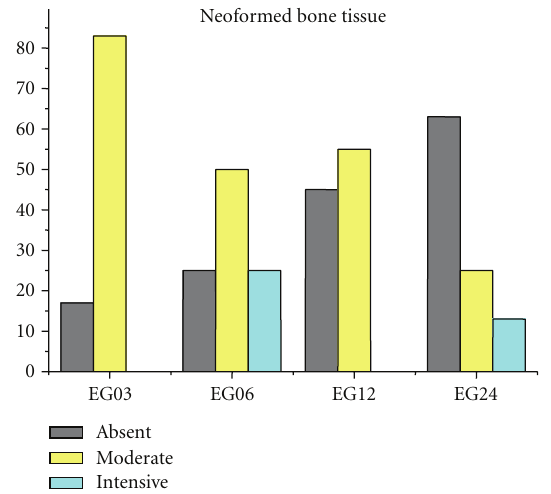
Figure 12: Mean neoformed bone tissue of EGs. Absence: 37%, moderate presence: 53%, and intensive presence: 10%.